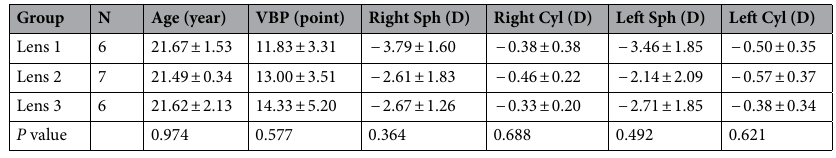
Table 2. General information of study